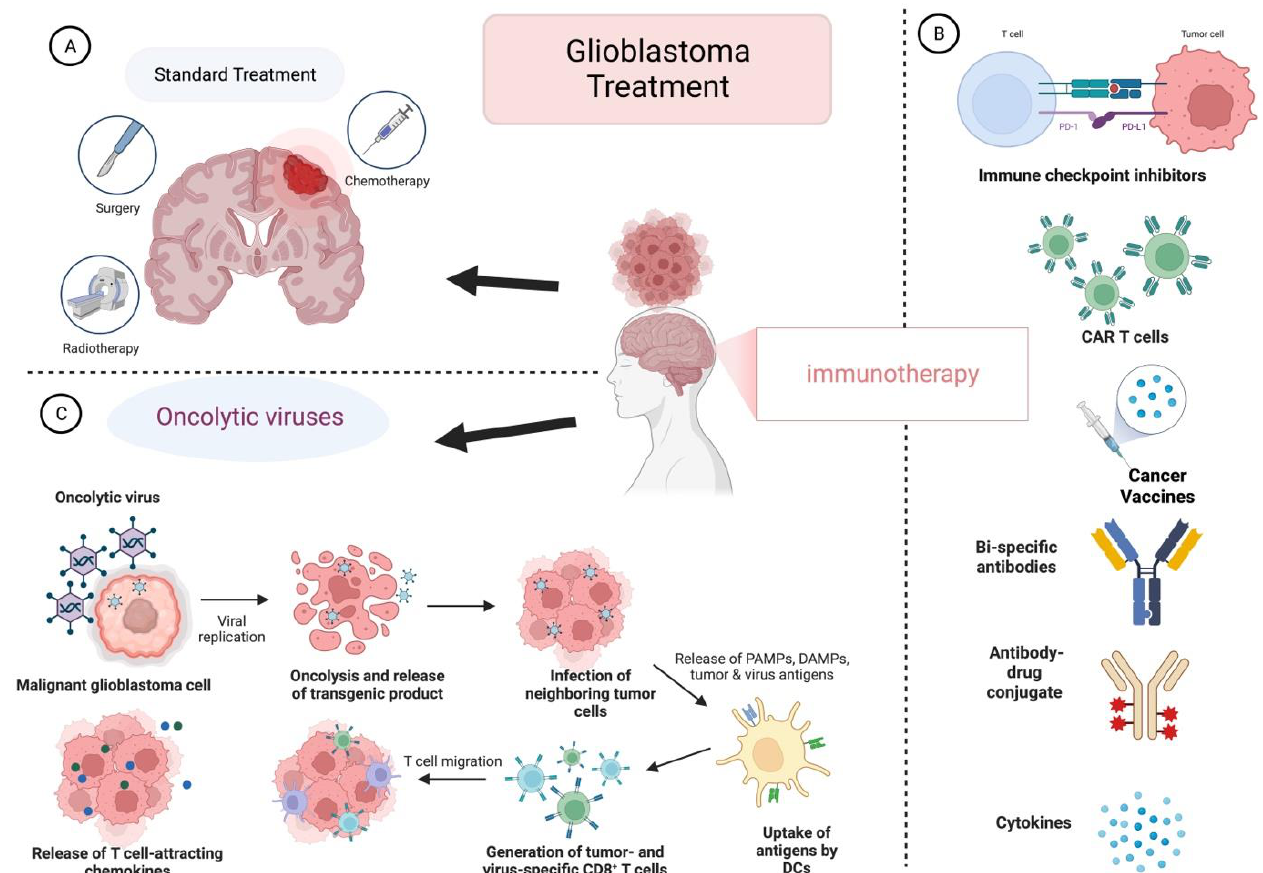
Figure 1. GB treatment types. ( A ) standard treatment regimens include surgical resection, chemotherapy, and radiotherapy. ( B ) Immunotherapeutic approaches include various types to activate the antitumor immunological response. ( C ) Virotherapy is promising because the oncolytic virus kills tumor cells using direct oncolysis and immunogenic cell death. The figure is created with the aid of BioRender.com.